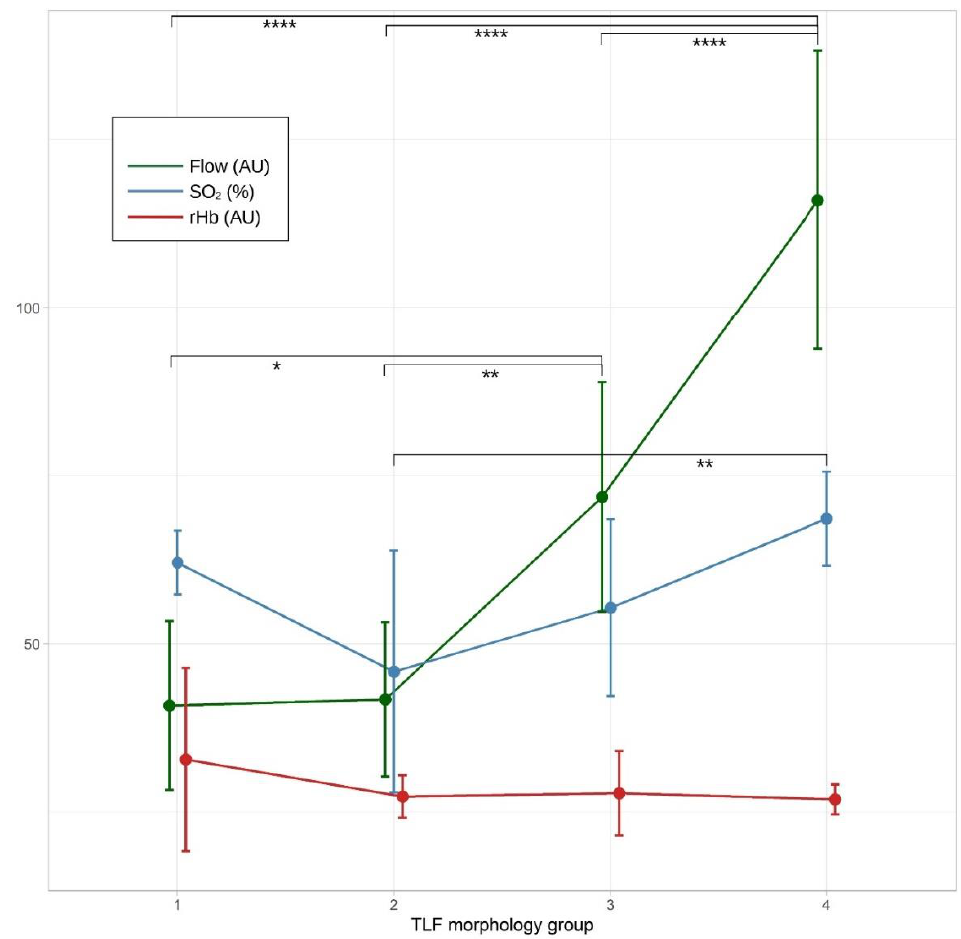
Figure 5. Changes in lumbar microcirculation between the thoracolumbar fascia morphology groups (group 1: very disorganized ( n = 5), group 2: somewhat disorganized ( n = 7), group 3 somewhat organized ( n = 9), group 4: very organized ( n = 9)). SO 2 , oxygen saturation; rHb, relative hemoglobin; AU, arbitrary units. Error bars represent the standard deviation. Significant at the level * p < 0.05, ** p < 0.01, **** p < 0.0001.